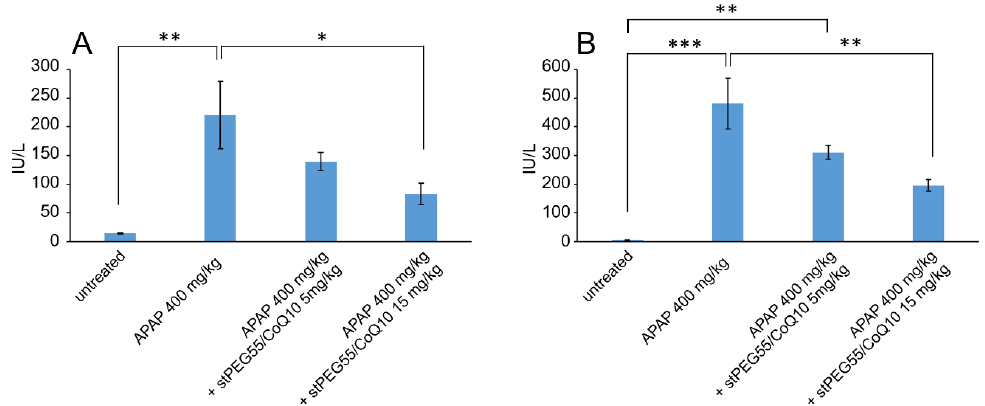
Figure 5. The effect of stPEG55/CoQ10 micelle treatment on aspartate aminotransferase (AST) ( A ) and alanine aminotransferase (ALT) ( B ) levels. Mice were treated with stPEG55/CoQ10 micelle (5, 15